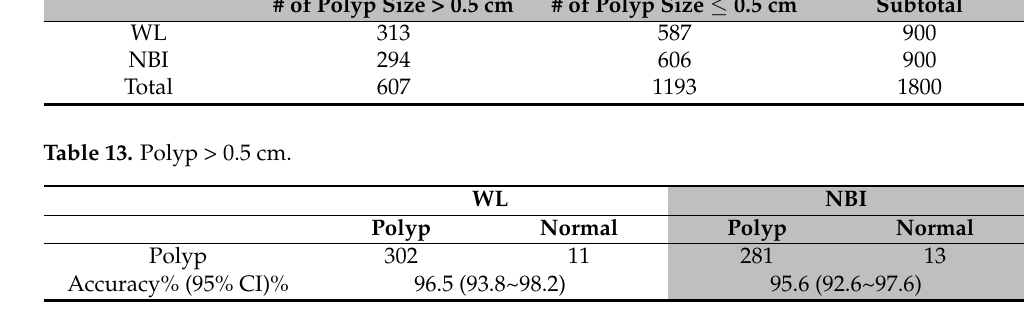
Table 12. The image number of polyps size greater and smaller than 0.5 cm. # of Polyp Size > 0.5 cm